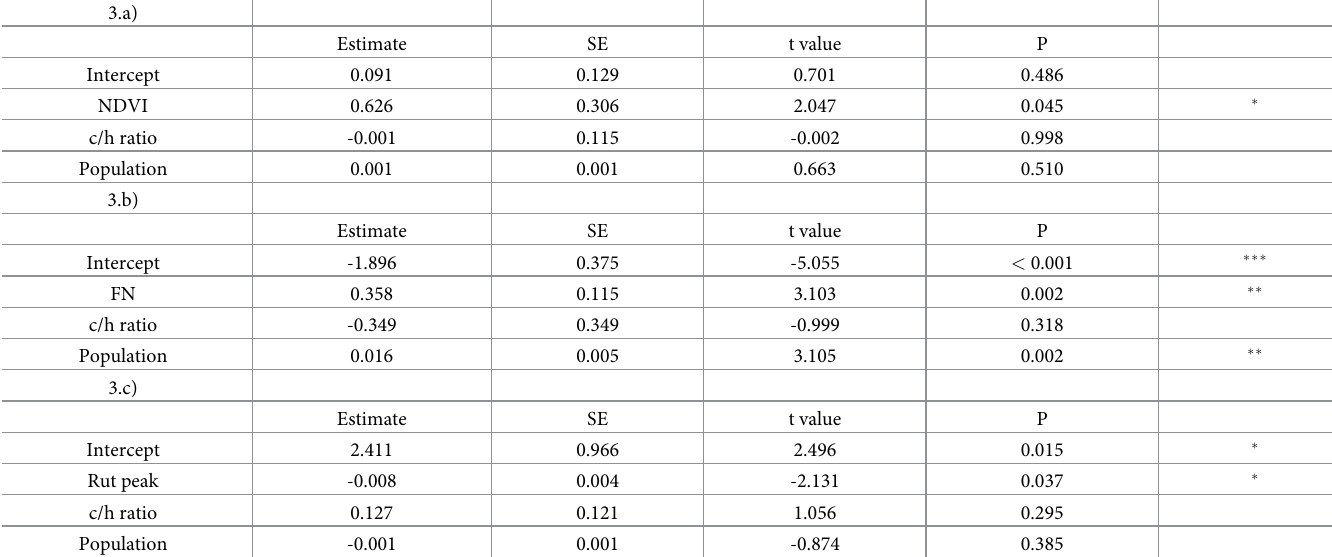
Table 3. Models for the response variable calves/hind ratio and the fixed factors calves/hind ratio in the previous year, population density and spring-summer NDVI (3.a), FN content (3.b) or rut peak date in julian days (3.c). Observation point was added as random factor only in model b (variance = 0. 031, SD = 0.177) because of the absent of variance in the other